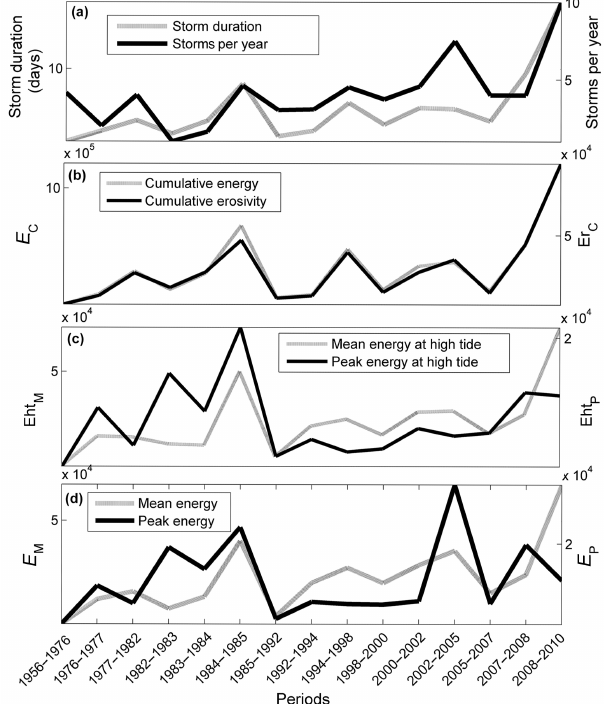
Figure 3. Temporal evolution of energetic parameters during the studied period: energy ( E ), energy at high tide (Eht), number of storms and storm duration. The dates of the available photographs are shown with vertical lines. The effect of wave transformation on E and Eht is shown for the Cádiz site.